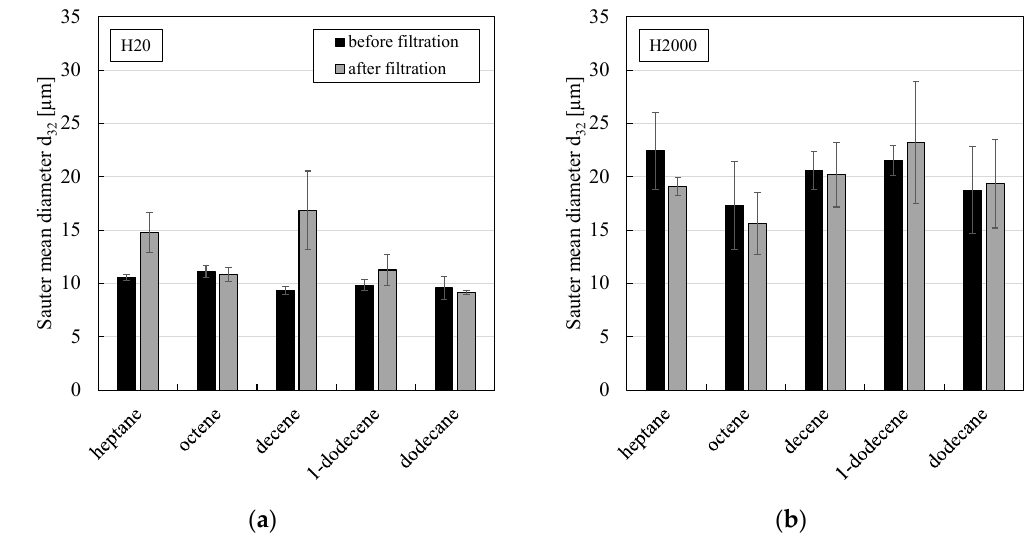
Figure 9. Sauter mean diameter against organic solvent type of w/o PEs stabilized by 0.5 wt.% of particle type ( a ) H20 or ( b ) H2000 before and after the filtration. All experiments were conducted at least in duplicate and mean values are shown. Error bars represent the standard deviation.